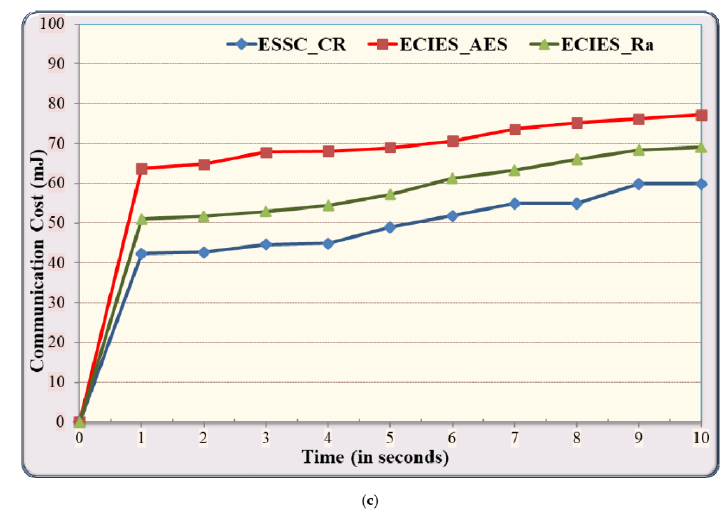
Figure 7. Performance comparison between ESSC cryptographic and baseline algorithms on IIoT ( a ) Execution Time; ( b ) Function Calls; ( c ) Energy